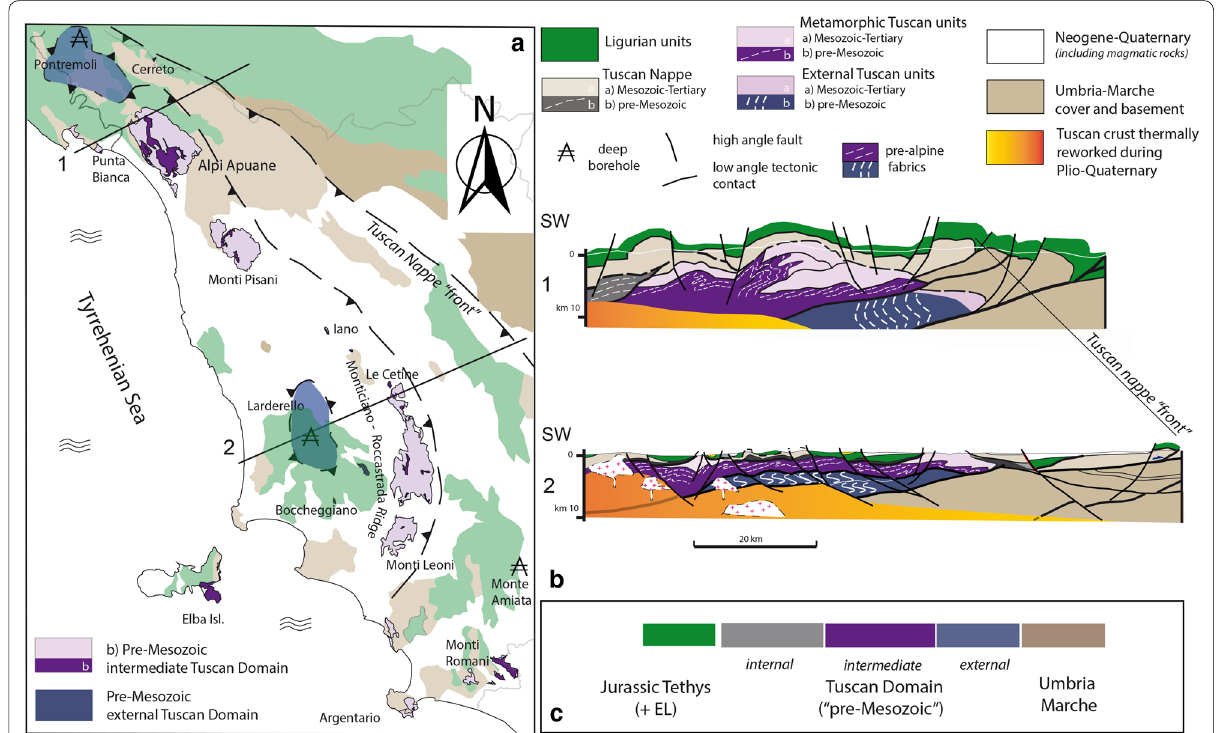
Fig. 2 a Tectonic map of Northern Apennines with the main pre-Mesozoic exposures of the Tuscan metamorphic units and of the external Tuscan domain in the subsurface (Pontremoli and Larderello-Travale deep wells); b geological cross sections of the Northern Apennines north and south of Arno, with indication of the pre-Mesozoic occurences; c simplified Mesozoic paleotectonic frame showing the relative pre-Mesozoic position of the Tuscan domains within